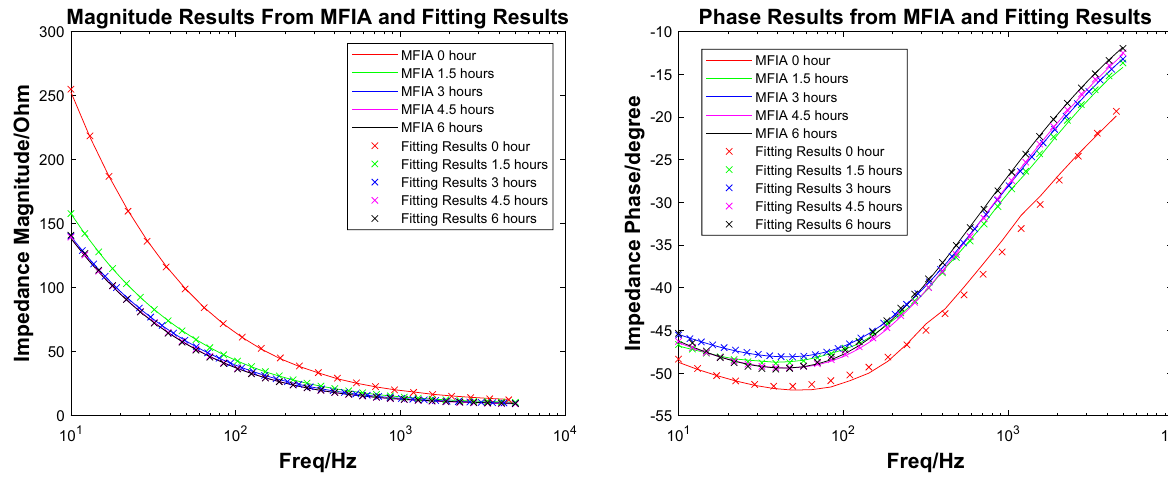
Figure 10. The impedance measurement from MFIA and the fitting